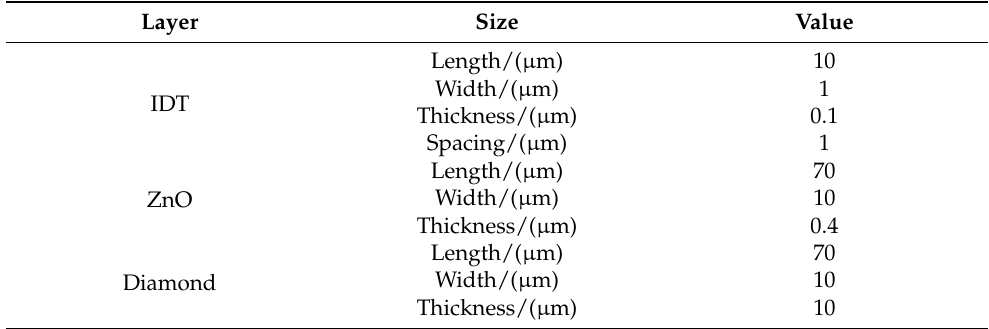
Table 1. Simulation structure parameters of the phonon piezoelectric device of the NV center.